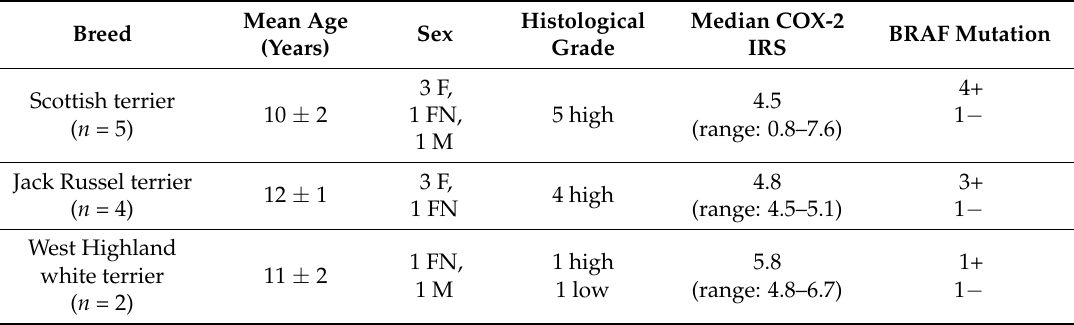
Table 1. Terriers: signalment, histological grade, cyclooxygenase-2 expression, and BRAF mutation in transitional cell carcinoma ( n =